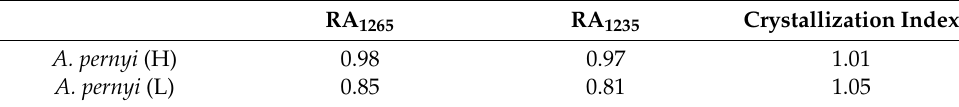
Table 3. The crystallization index of silk measured by infrared absorption spectroscopy ( RA is relative absorbance).